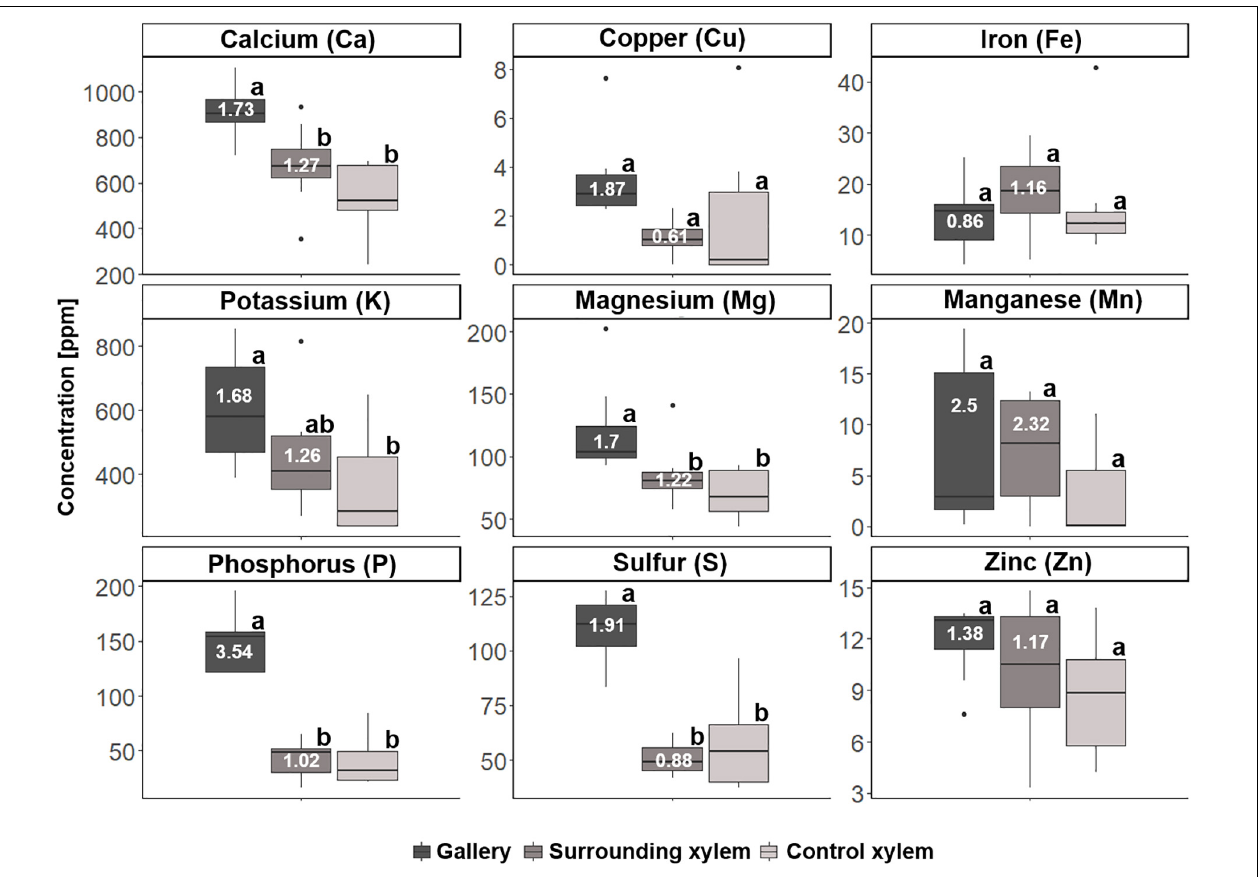
FIGURE 8 | Concentrations of the different elements for the three types of samples taken from Trypodendron lineatum ( N = 7–8 per group): (i) gallery, (ii) xylem next to gallery, and (iii) control xylem. Elemental abundances are given in parts per million (ppm). Different letters next to boxplots (a, b) indicate significant differences between the respective group per individual element. Enrichment ratios (white numbers) for treatment i and ii were added to boxplots for each